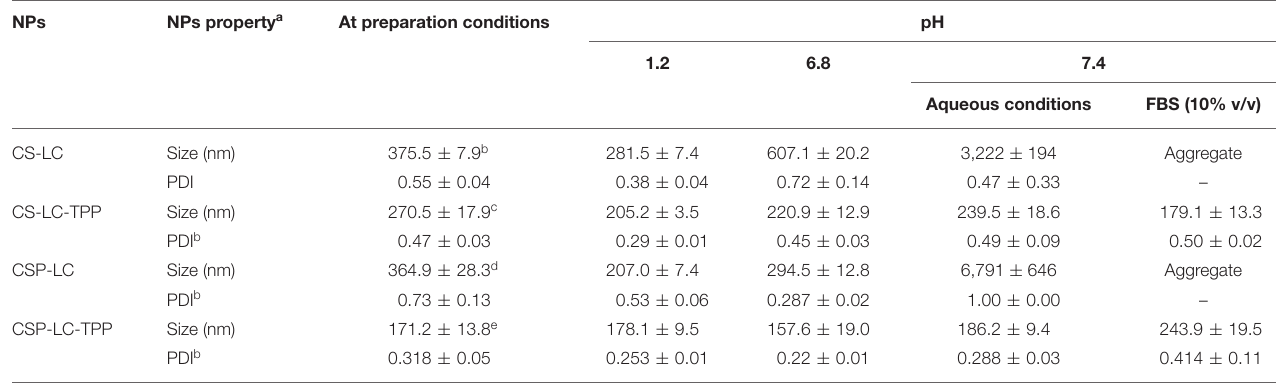
TABLE 2 | Size properties of unloaded-NPs under varying pH and 10% FBS solution.